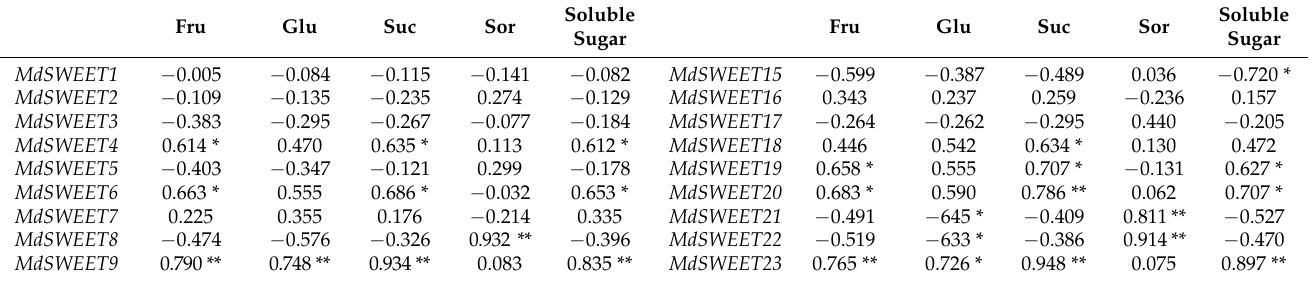
Table 4. Correlation analysis of expression levels and main sugar or soluble sugar content during the fruit developmental period. Correlation analysis of the expression levels and main sugar or soluble sugar content during the fruit developmental period was performed using Duncan (cid:48) s multiple range test. Significant and highly significant differences are indicated by * p < 0.05 and ** p < 0.01,